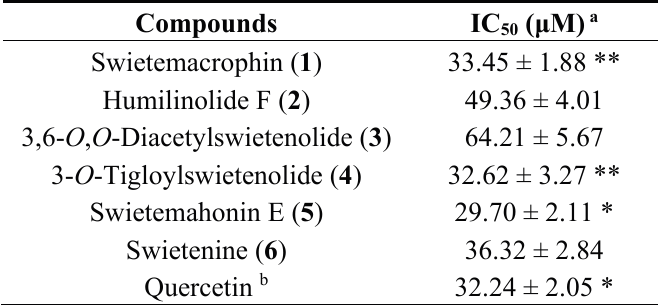
Table 4. Inhibitory effects of compounds 1 – 6 from the seed of S. macrophylla on nitric oxide (NO) generation by RAW264.7 murine macrophages in response to lipopolysaccharide